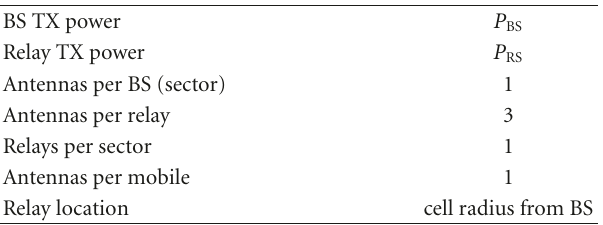
Table 2: System parameters for shared relay model. The main di ff erences between the shared relay model and the one-way relay are the number of antennas per relay, the relay transmit power, and the number of relays per sector. Since over a large network there will be approximately 3 times fewer relays for the shared model than the one-way relay model, shared relays are given 3 times the transmission power and 3 times the